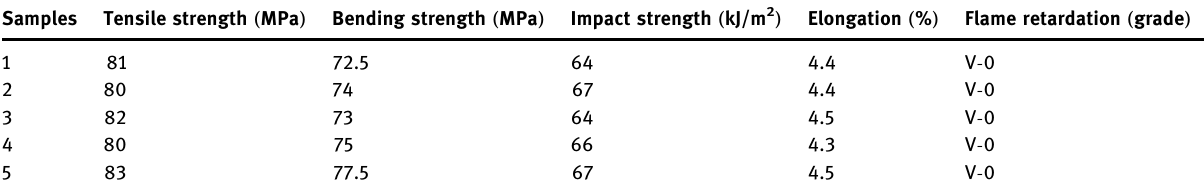
Table 2: Initial properties of the plate before adding the “ supporting mold ”